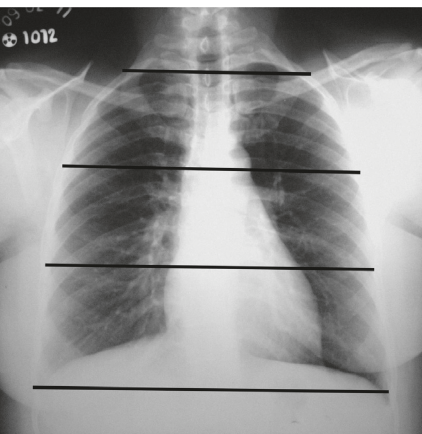
Figure 1: Posteroanterior CXR. Black lines demarcate the limits of the six